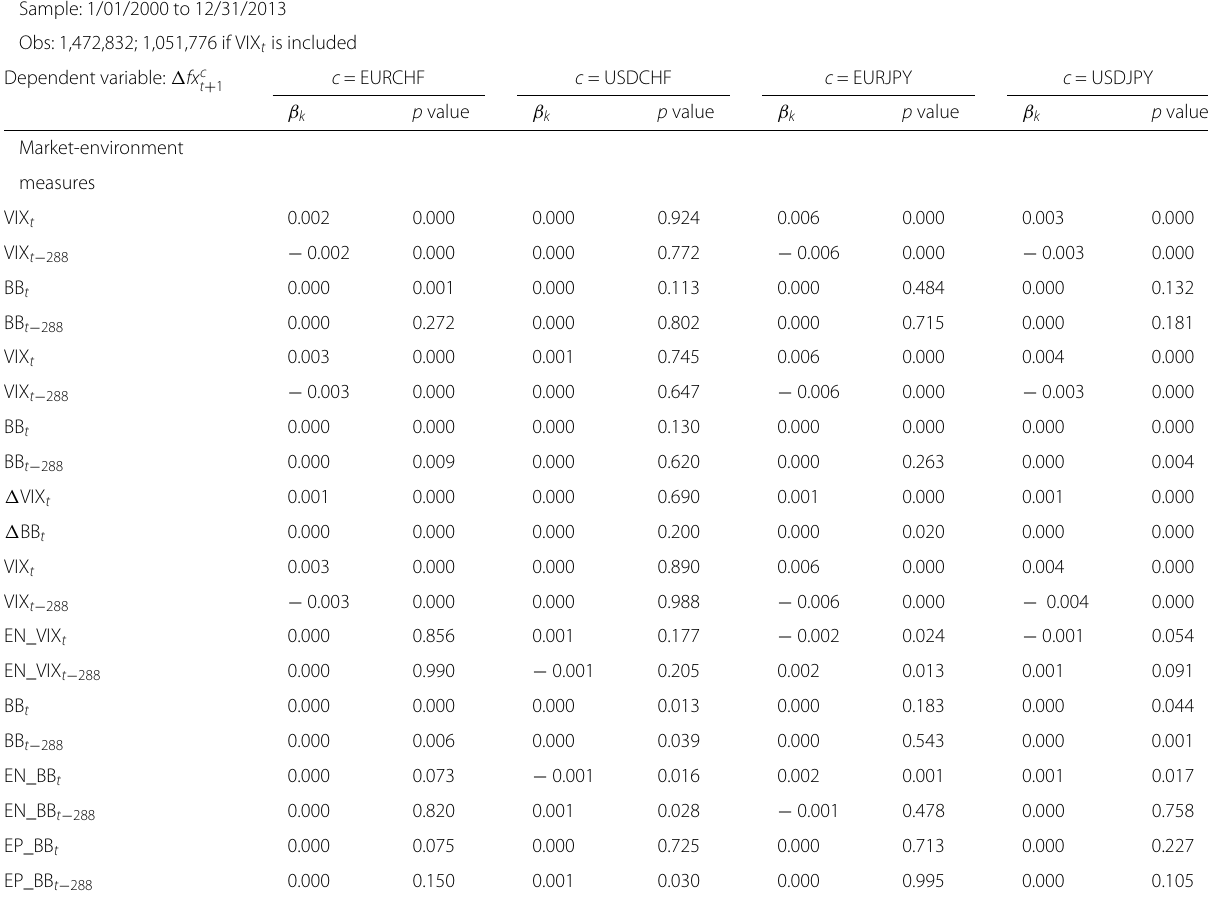
Table 8 Role of the market environment Sample: 1/01/2000 to